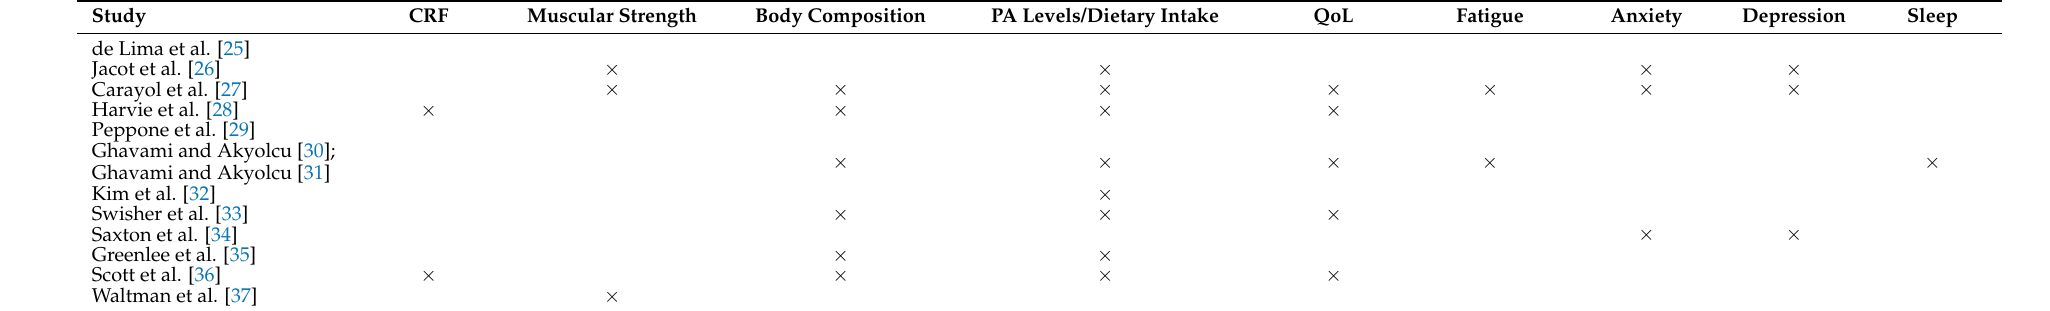
Table 6. Summary of the improvements found in the outcome variables by